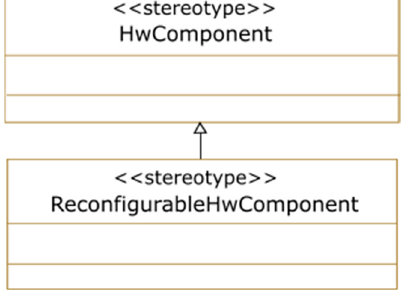
Figure 2. Reconfigurable hardware component stereotype.